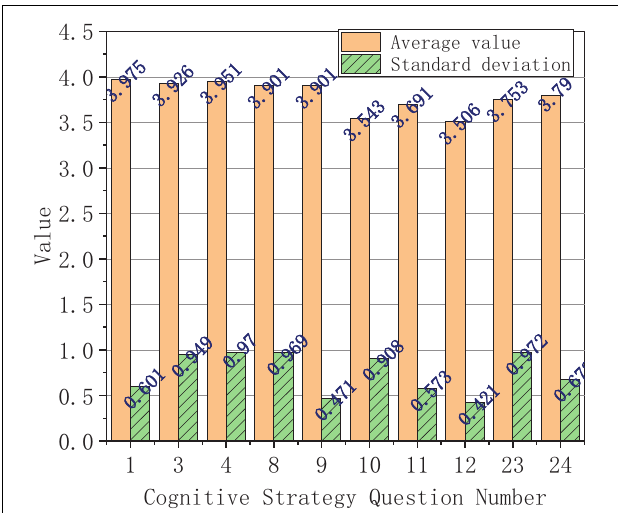
FIGURE 5 | Analysis of the top 10 types of learning strategies used in Chinese